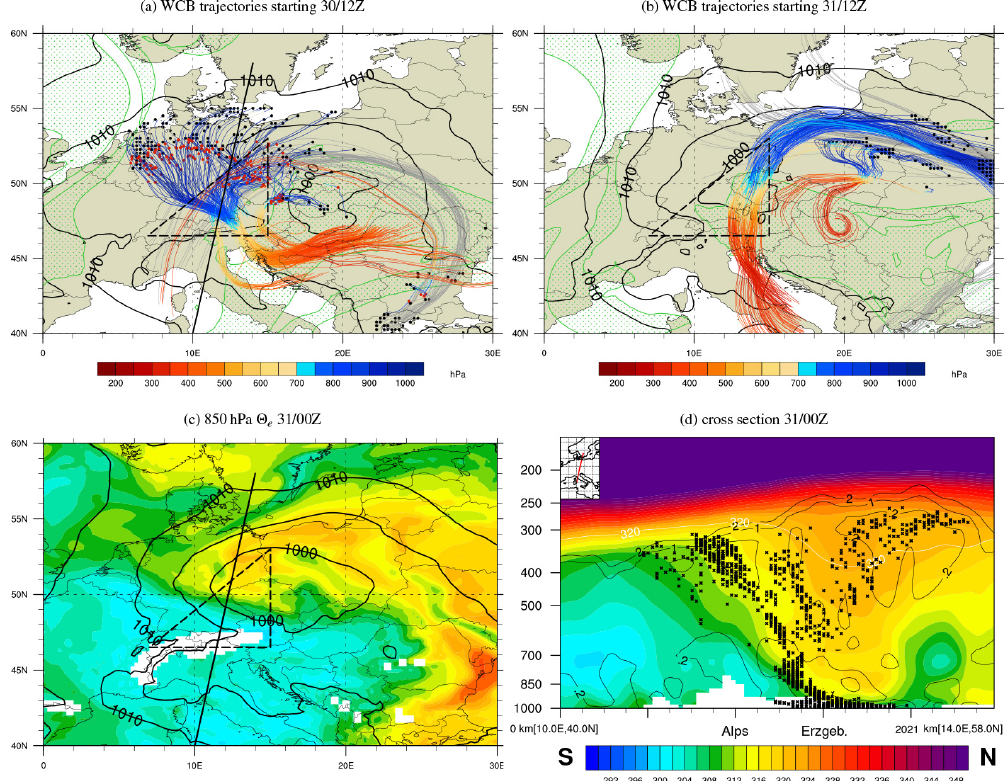
Figure 6. (a) : WCB trajectories starting on 30 May 2013, 12:00, and ending on 1 June 2013, 12:00UTC, sea level pressure (slp) at the WCB starting time (black every 5hPa) and PV at 320K (green hatched > 2PVU) at the WCB end time. Black dots mark the trajectory start locations, red dots the locations of the air parcels after 12h (31 May 2013, 00:00UTC). “Equatorward ascending WCBs” are coloured with pressure (see colour bar). (b) : for WCB trajectories starting on, 31 May 2013, 12:00UTC, and ending on 2 June 2013, 12:00UTC, and without red dots. (c) : 850hPa θ e (shaded every 2K as in d ) and slp (black, every 5hPa) on 31 May 2013, 00:00UTC. (d) : Cross section on 31 May 2013, 00:00UTC, of θ e (shaded every 2K as in c ), θ (white contour for 320K), PV (black, 0.2, 1.0, and 2.0PVU), and every 5th WCB trajectory intersection point. Triangle in (a–c) highlights the region affected by heavy precipitation. Black line in (a) and (c) shows the location of the cross section in (d)